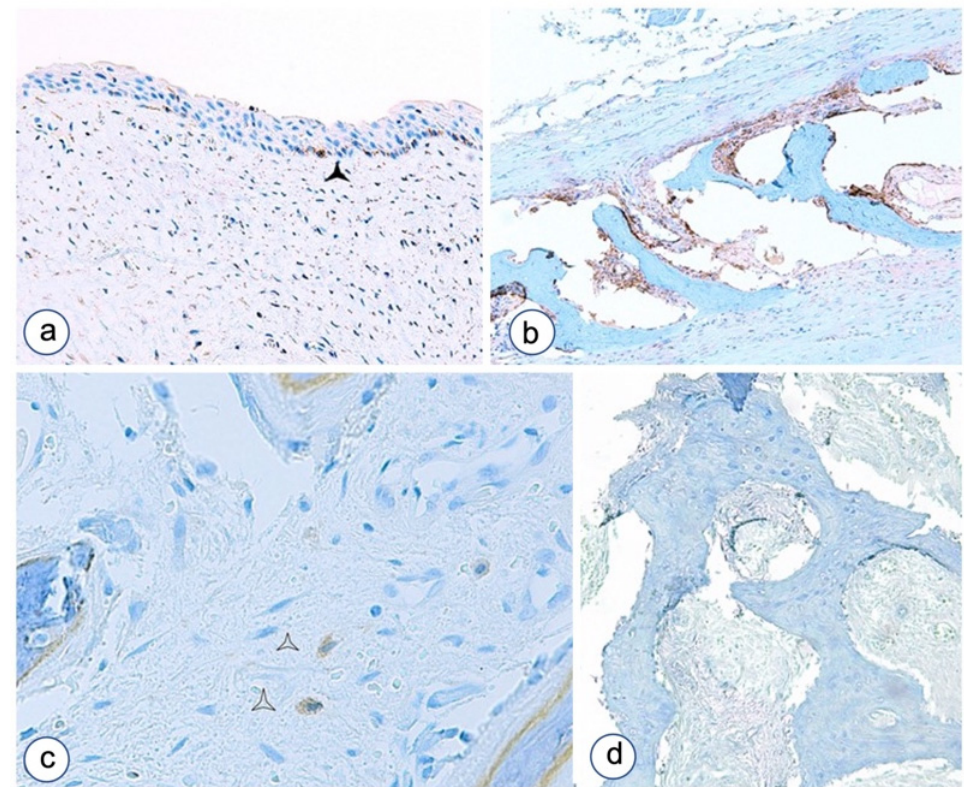
Figure 5. OB-cadherin lack of expression in FD of the jaws. ( a ) Positive control of OB-cadherin in basal layer of developmental odontogenic cyst (black star) and focal fibroblasts of connective tissue wall. ( b ) Strong expression of OB-cadherin in the remodeling bone surrounding odontogenic cyst, further magnification of Figure 3c. ( c ) Precursors of osteoblasts OB-cadherin positive in mesenchymal stroma during normal bone remodeling (empty stars). ( d ) OB-cadherin lack of expression in FD of the jaw; LSAB-HRP, nuclear counterstaining with Gill’s type II hematoxylin. Magnifications, × 4 ( b , d ), × 10 ( a ), × 20 ( c